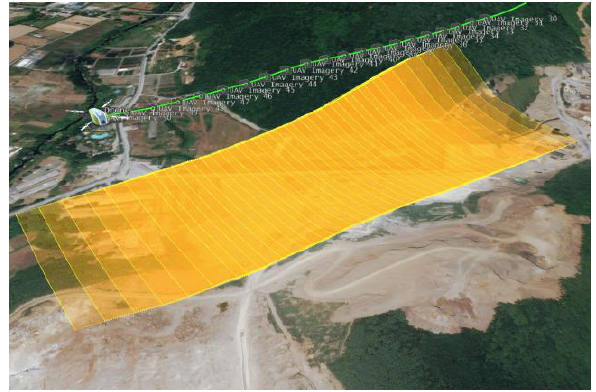
Figure 5 . An UAV photogrammetric flight visualization